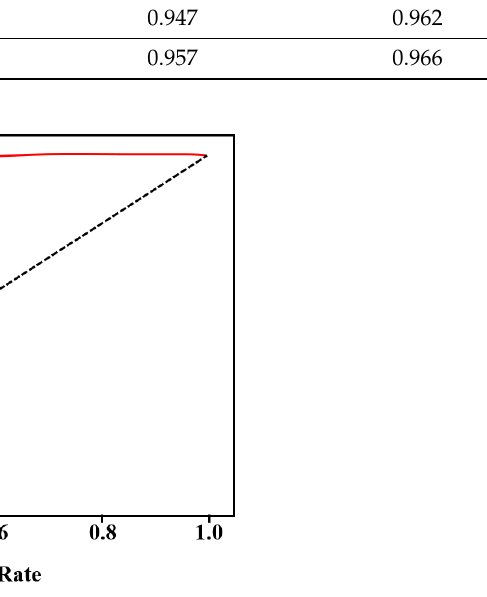
Figure 8. ROC curve of vehicle detection results using EfficientDet-D2 for fold set 1 (AUC =